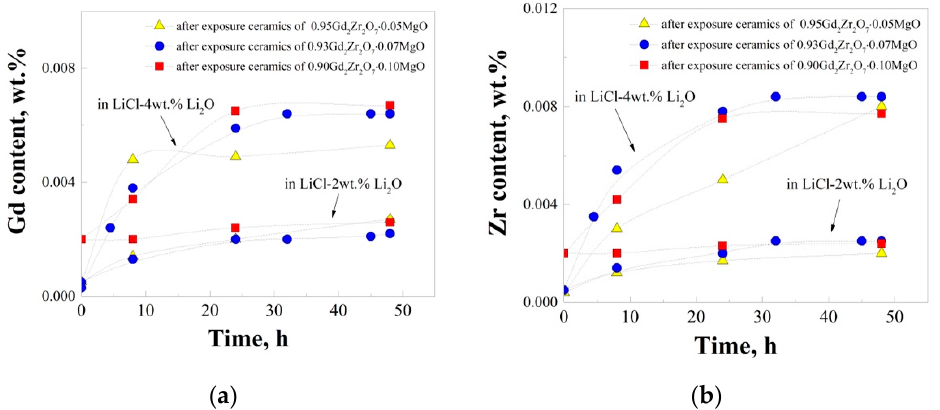
Figure 15. ( a ) Chemical analysis data on the content of Gd in the melts after 48 h of exposure for (1- x )Gd 2 Zr 2 O 7 · x MgO. ( b ) Chemical analysis data on the Zr content in the melts after 48 h of holding for (1- x )Gd 2 Zr 2 O 7 · x MgO.